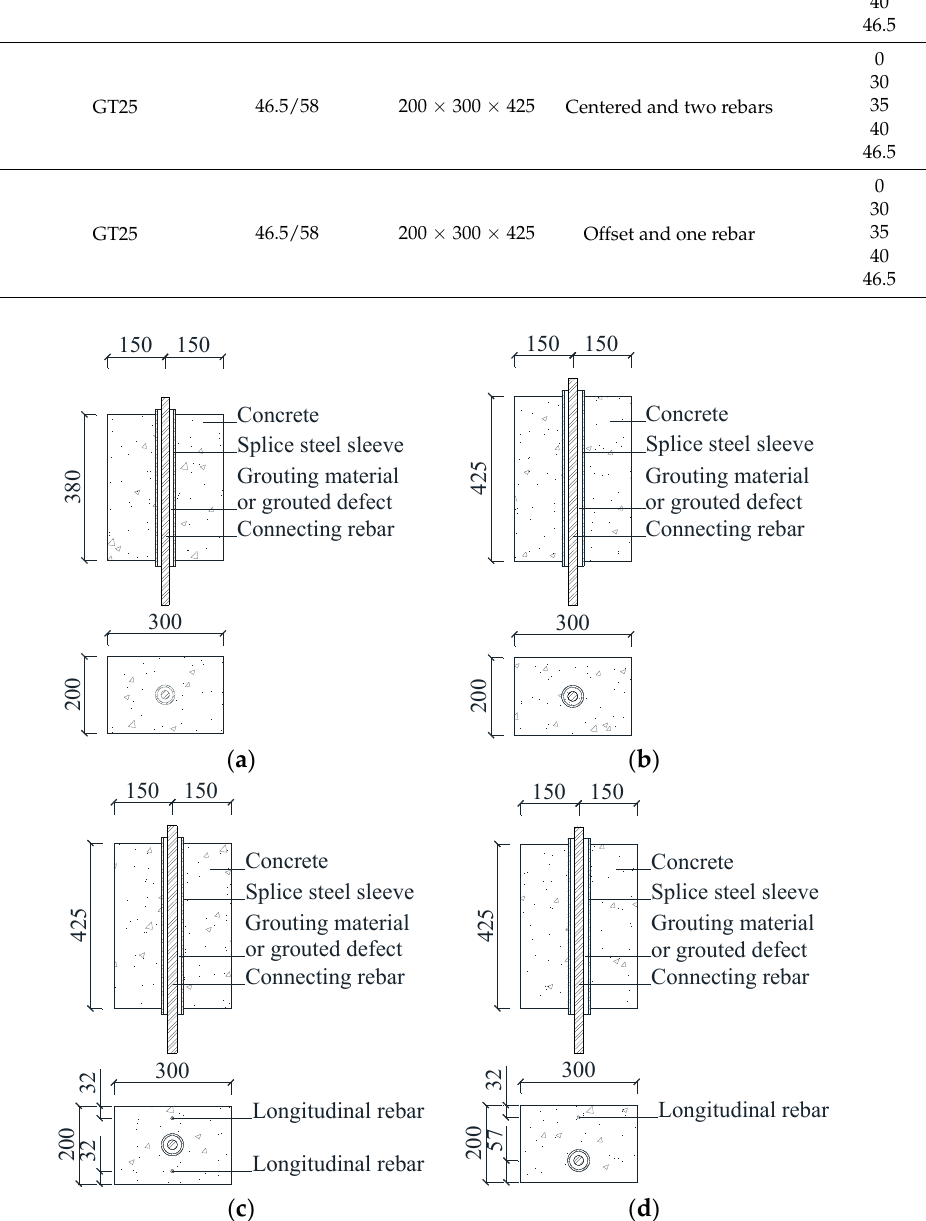
Figure 1. The schematic diagram of the concrete specimens. ( a ) SJ1 group, ( b ) SJ2 group, ( c ) SJ3 group, ( d ) SJ4 group.